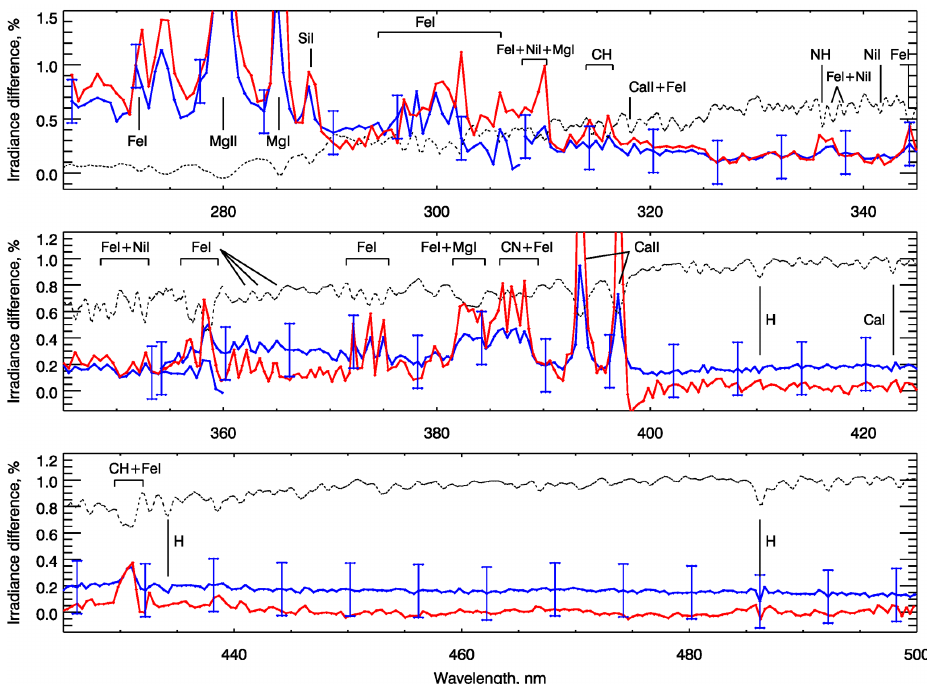
Figure 8. Solar spectral irradiance (SSI) variability in cycle 24. The blue line shows the normalized long-term difference (2012–2014 vs. 2007–2009, i.e., the solar maximum vs. solar minimum) as observed by OMI with representative ± 0.2% errors. The red line follows the properly normalized GOME-2 data derived from the rotational ( ∼ 27 days, the local maximum flux vs. the adjacent minimum) variability in 2012–2013. The GOME-2 data were adjusted to the OMI SSI by a multiplicative factor that matches the 27-day and solar cycle amplitudes in the 325–335nm range. Note that the ∼ 3 times higher GOME-2 spectral resolution leads to substantially higher SSI amplitudes at prominent spectral lines and blends (e.g., CaII 393, 396nm). For reference, the scaled solar spectrum is shown as a dotted line.